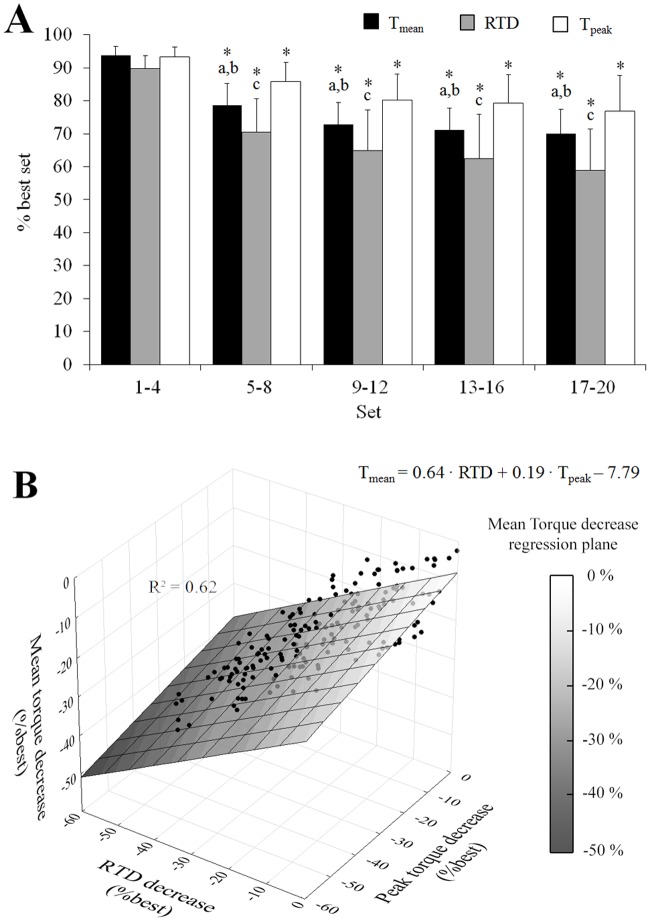
Variations of the torque variables during the exercise protocol.Mean torque (Tmean), peak torque (Tpeak) and rate of torque development (RTD) decrease over the 20 sets (A) as well as the multiple linear regression of Tmean predicted by Tpeak and RTD (B) is presented. Data are mean ± SD for four sets. Significant difference from set 1–4: * <0.05. Significant difference between Tmean and RTD from the same sets: a; Significant difference between Tmean and Tpeak from the same sets: b; Significant difference between RTD and Tpeak from the same sets: c.